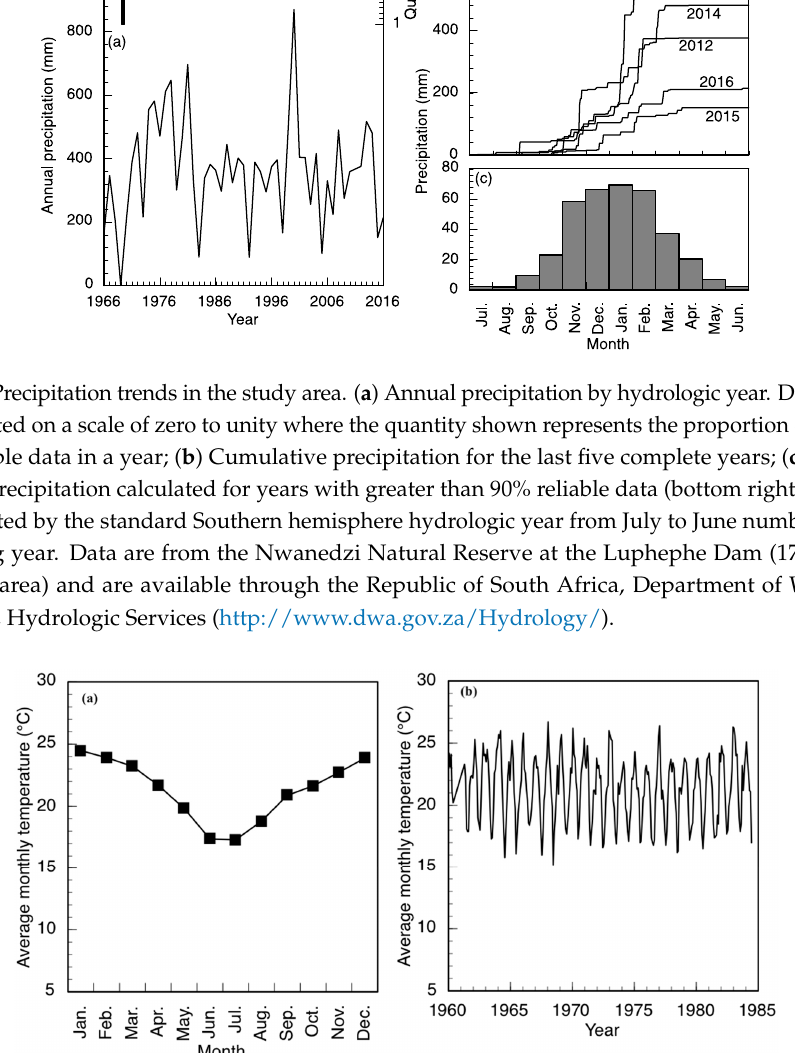
Figure 3. The mean monthly temperature in the region recorded at Punda Milia. ( a ) Mean monthly temperature based on the means from 1962–1984. ( b ) Mean monthly temperature record. Data are available from the National Oceanic and Aviation Administration (U.S.), National Climatic Data Center, Climate Data Online service (https://www.ncdc.noaa.gov/cdo-web/). Agriculture occupies the greatest land cover in the valley. Most households are engaged in some level of farming. Crops cultivated include maize and vegetables, and tree fruits include mangos and citrus fruits. Livestock is prevalent in the area with chickens, goats, and cattle. Smaller animals typically remain closer to households and larger animals graze throughout the region without